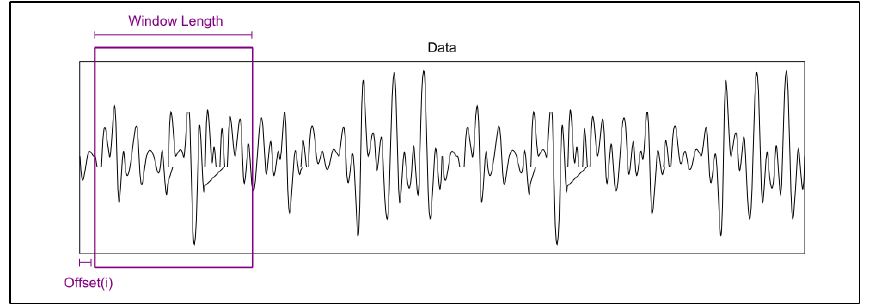
Figure 5. A typical example of a window function